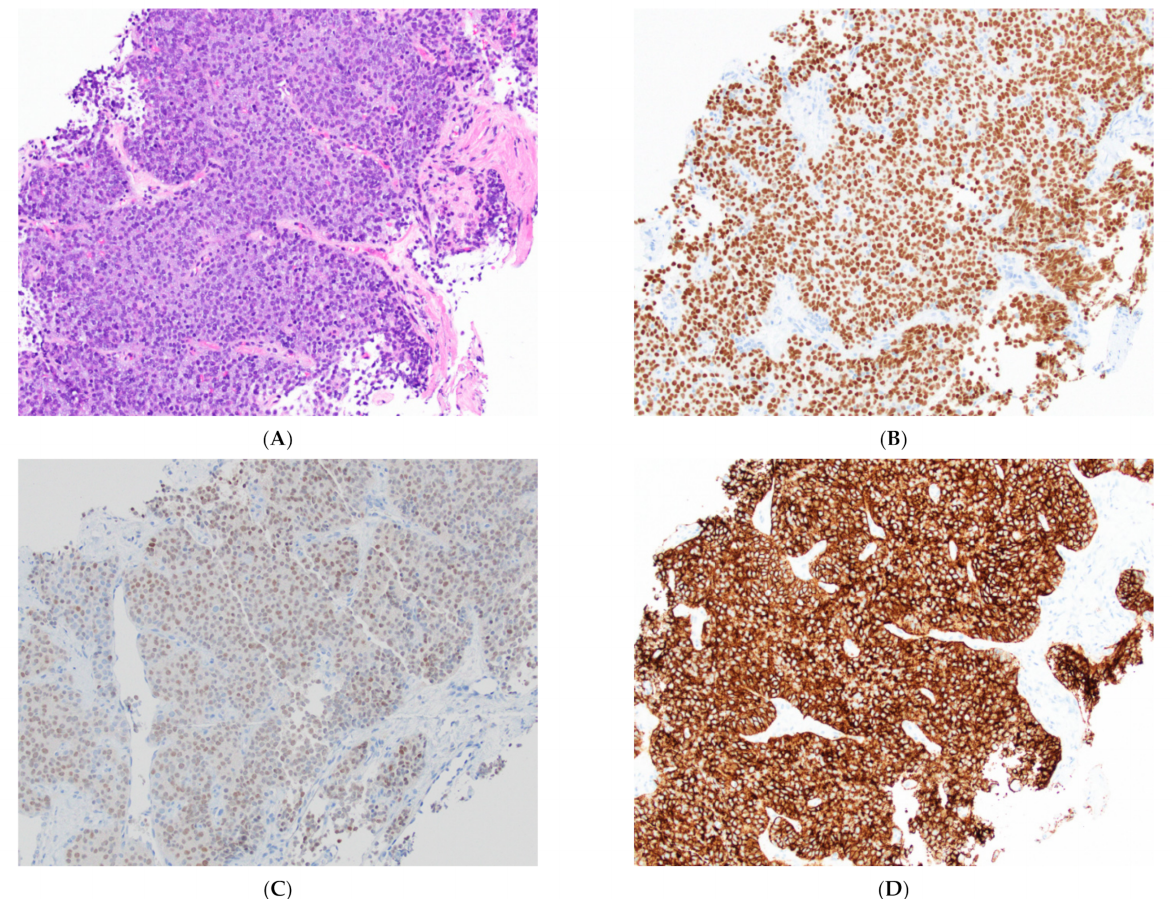
Figure 8. Immunocytochemical profile of thymic carcinoma. ( A ) H&E stain on a thymic carcinoma biopsy. ( B ) Staining with p63 highlights epithelial cells, and ( C ) reactivity for PAX8 favors thymic origin. ( D ) Reactivity for CD117 is highly specific for thymic carcinoma in this setting. The epithelial cells are negative for CD5 (not displayed), highlighting the poor sensitivity of immunocytochemical stains in thymic carcinoma. All images, 20 ×